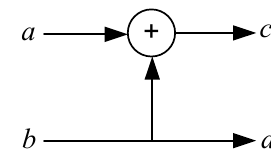
Figure 1: The Kernel encoding unit.